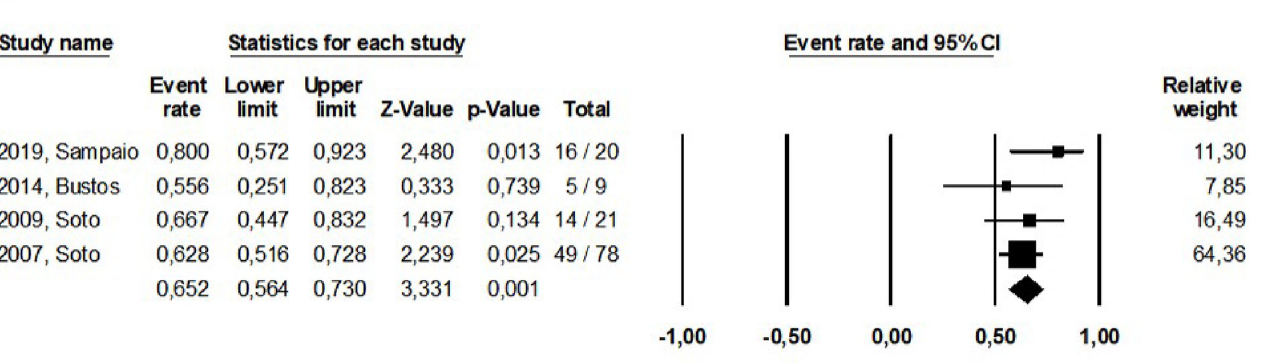
PLOS NeglectedTropical Diseases | https://doi.org/10.1371/journal.pntd.0010931 November17,